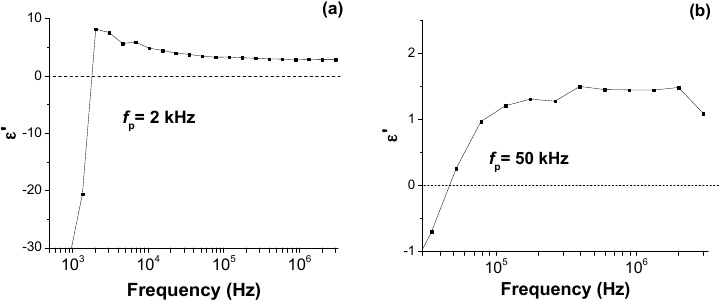
Figure 4. Real permittivity for ( a ) nontreated or pristine ICPM metacomposite and ( b ) plasma-treated IPM in the frequency range close to f p